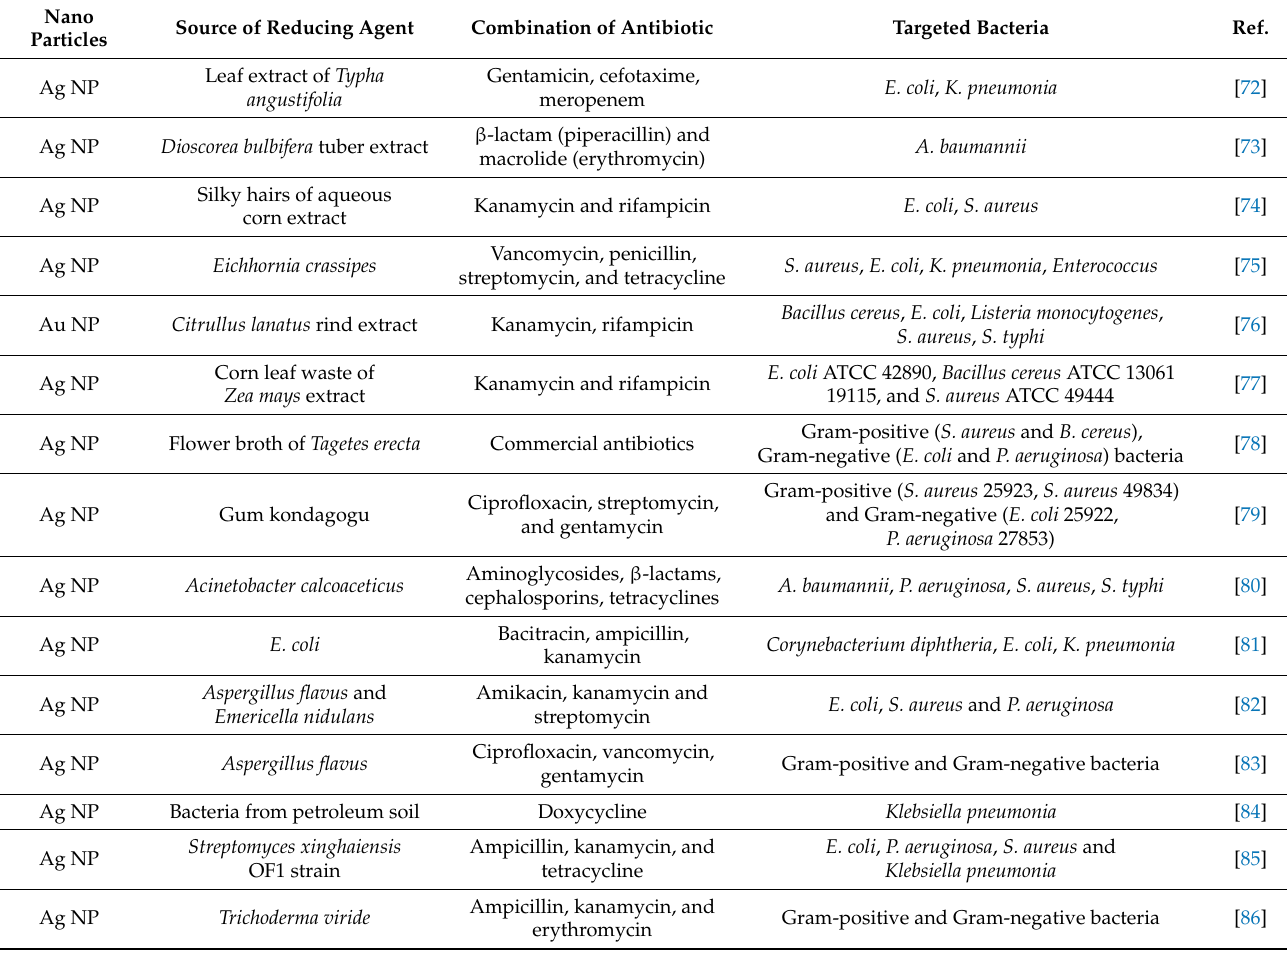
Table 2. The synergy of plant-based or microbial-based NPs and antibiotics for antibacterial